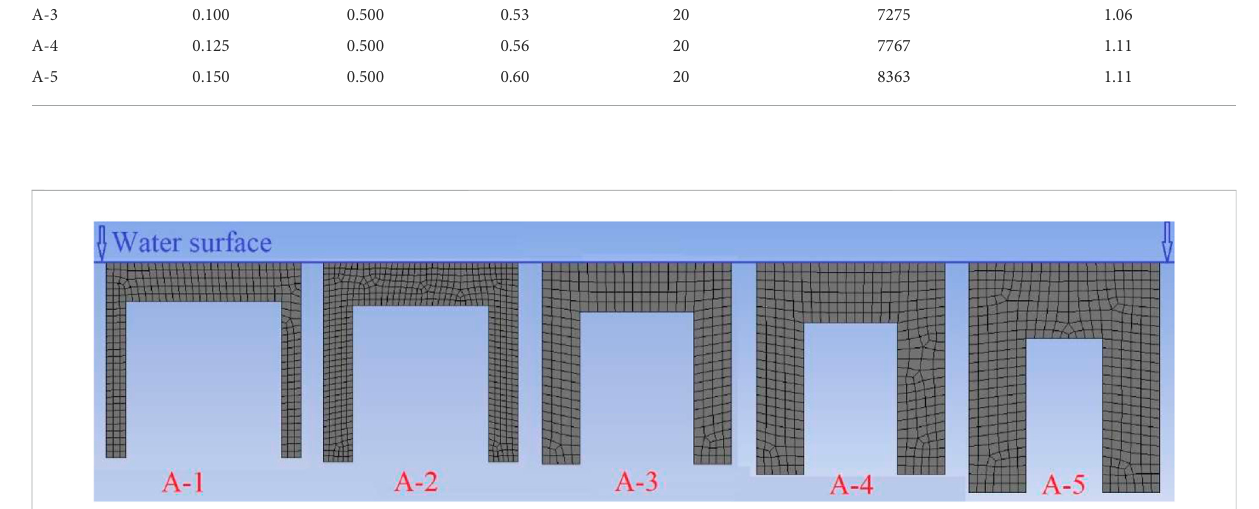
FIGURE 4 Five dual-chamber OWC WEC models with the chambers of different geometric